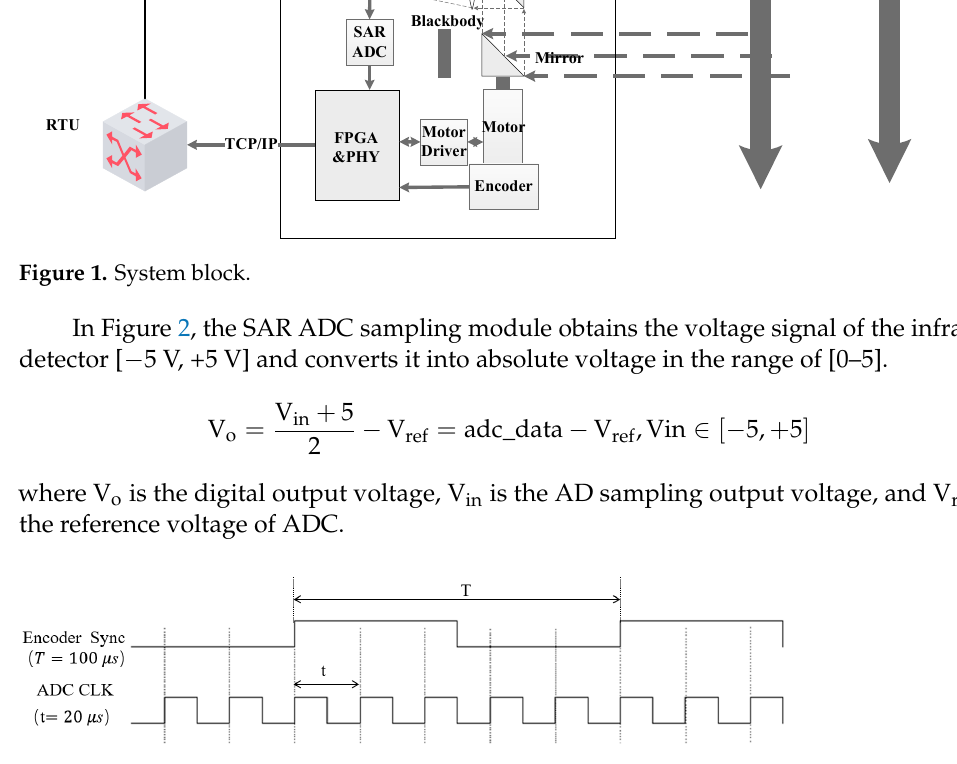
Figure 2. ADC sample based on equal angle scanning.